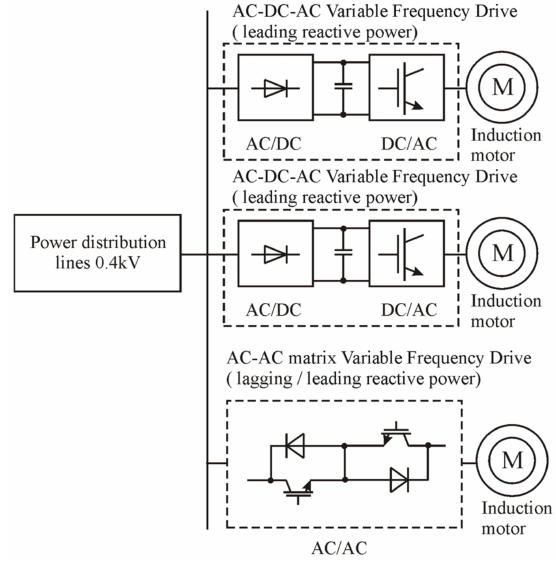
Figure 9. The structure of researched